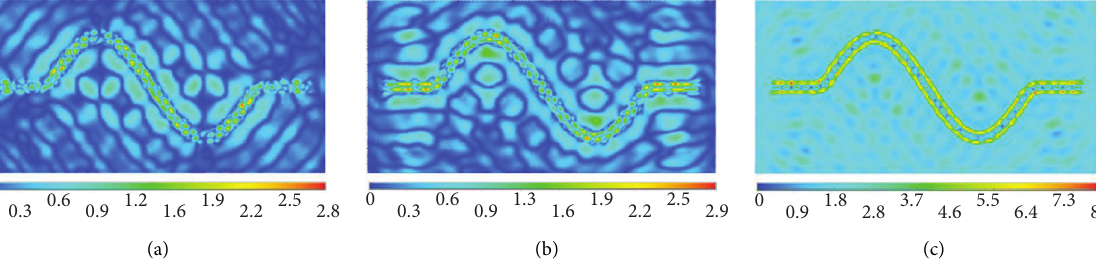
Figure 21: P wave incident ( f � 4.0Hz, H � 100m, C